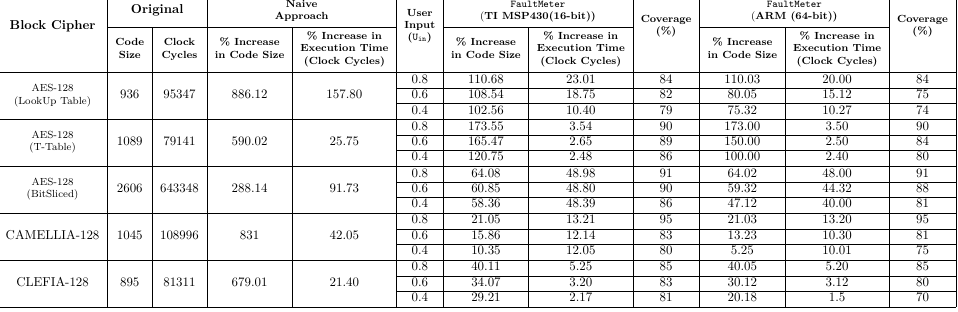
Table 4: Comparison of unprotected and naïvely protected implementations with FaultMeter based countermeasure addition. The table shows the percentage increase in code size, clock, along with fault coverage. The comparison is made on a TI MSP-430 (16-bit) and ARM(64-bit) processors with different user requirements. Original Naive Block Cipher